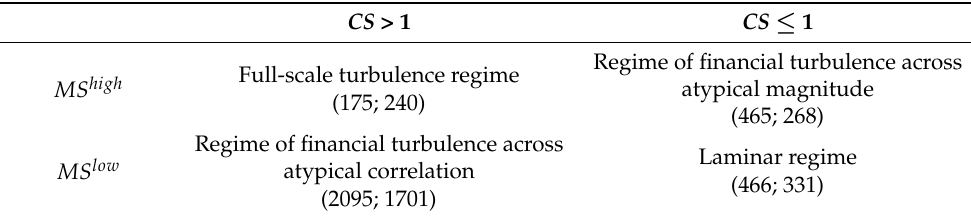
Table 2. The number of observations in the regime-based samples.